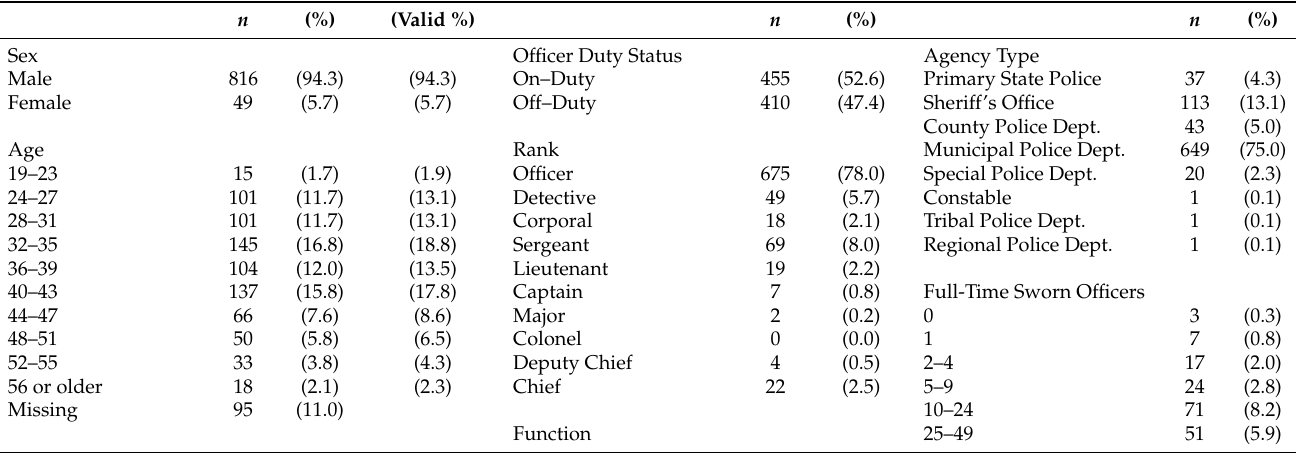
Table 1. Officer and agency characteristics in police crime arrest cases, 2005–2014 ( N =